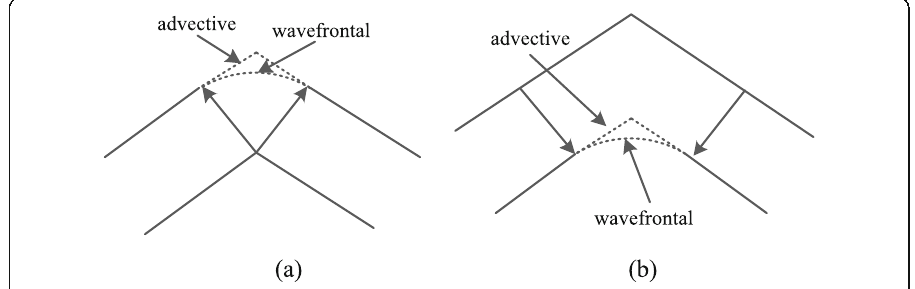
Fig. 4 Advection vs. wave-frontal propagation at expansion at a ( a ) convex corner and ( b ) concave